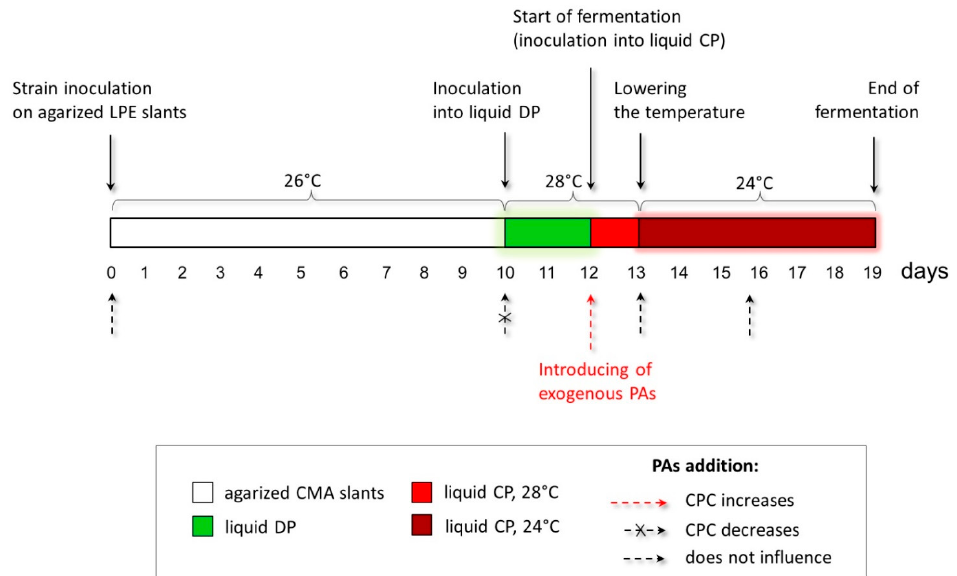
Figure 4. Optimization of the conditions for introducing exogenous polyamines (PAs) to increase cephalosporine C (CPC) production in the A. chrysogenum high-yielding (HY) strain. The red dashed arrow shows the optimal time for PAs’ addition to increase CPC production at the inoculation from liquid defined (DP) medium to liquid complex (CP) medium. Small dashed arrows mark the periods of strain cultivation when the addition of PAs does not affect CPC production. The small crossed-out dashed arrow marks the period when the addition of PAs leads to a decrease in CPC production.